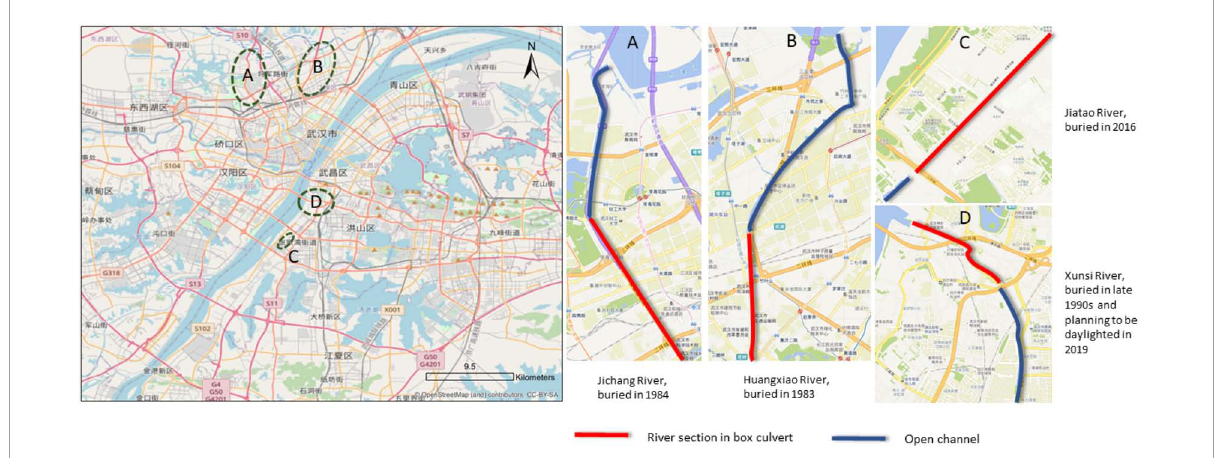
FIGURE13 Left: map showing four examples for river burial and plans for daylighting in Wuhan. Right: detailed maps for (A) the Jichang River, (B) Huangxiao River, (C) Jiatao River, and (D) Xunsi River. Map created by Yixin Cao, based on data from Open street map; Water Resources Bureau of Wuhan